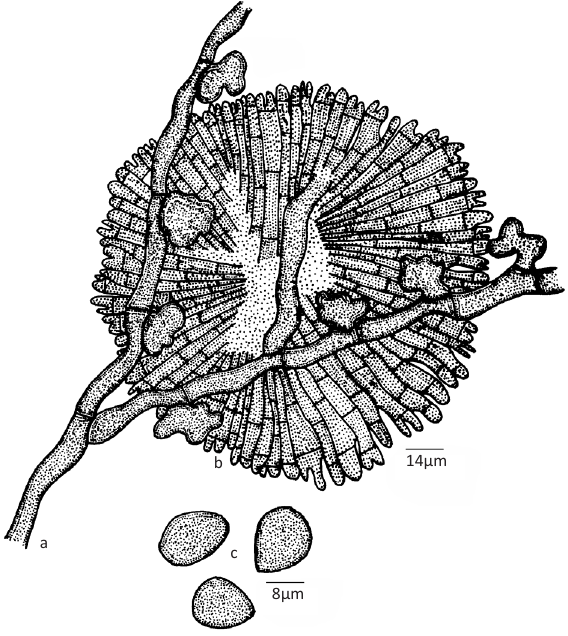
Figure 9. Asterostomella vernoniae sp. nov. a - Appressoriate mycelium; b - Pycnothyrium; c -